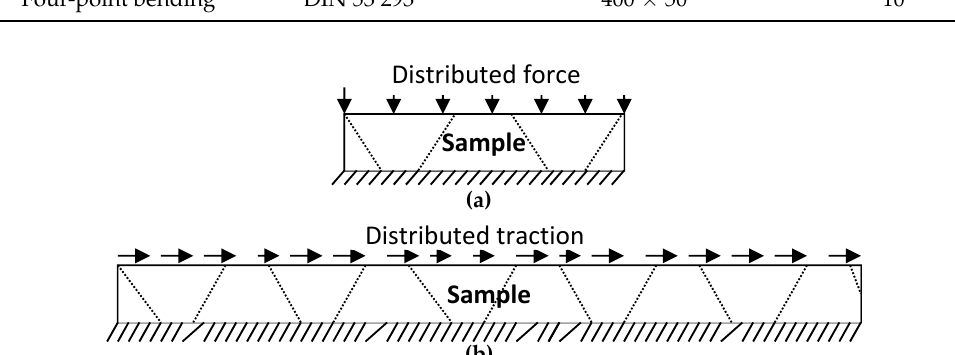
Figure 3 . Compression test ( a ), and shear test ( b ).